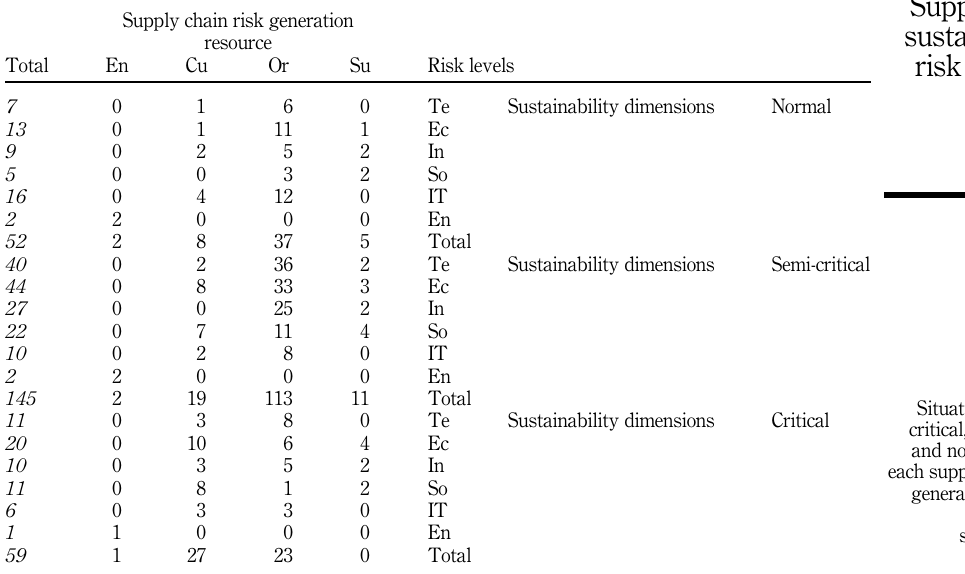
Table 6. Situation matrix of